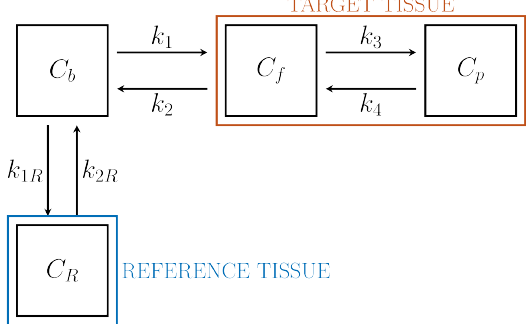
Figure 5. Compartment model for the reference